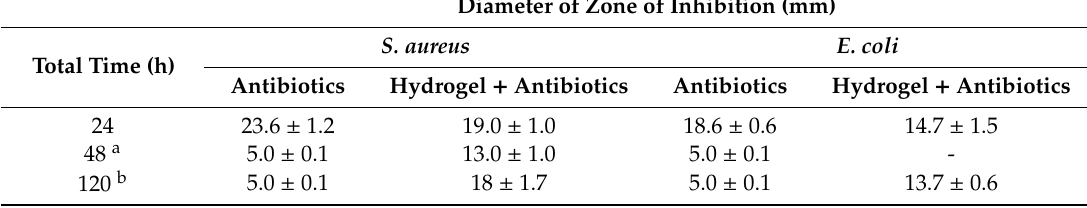
Table 3. Inhibitory e ff ect of PEG1000-3arm hydrogel discs loaded with antibiotics toward S. aureus and E. coli ( n = 3).